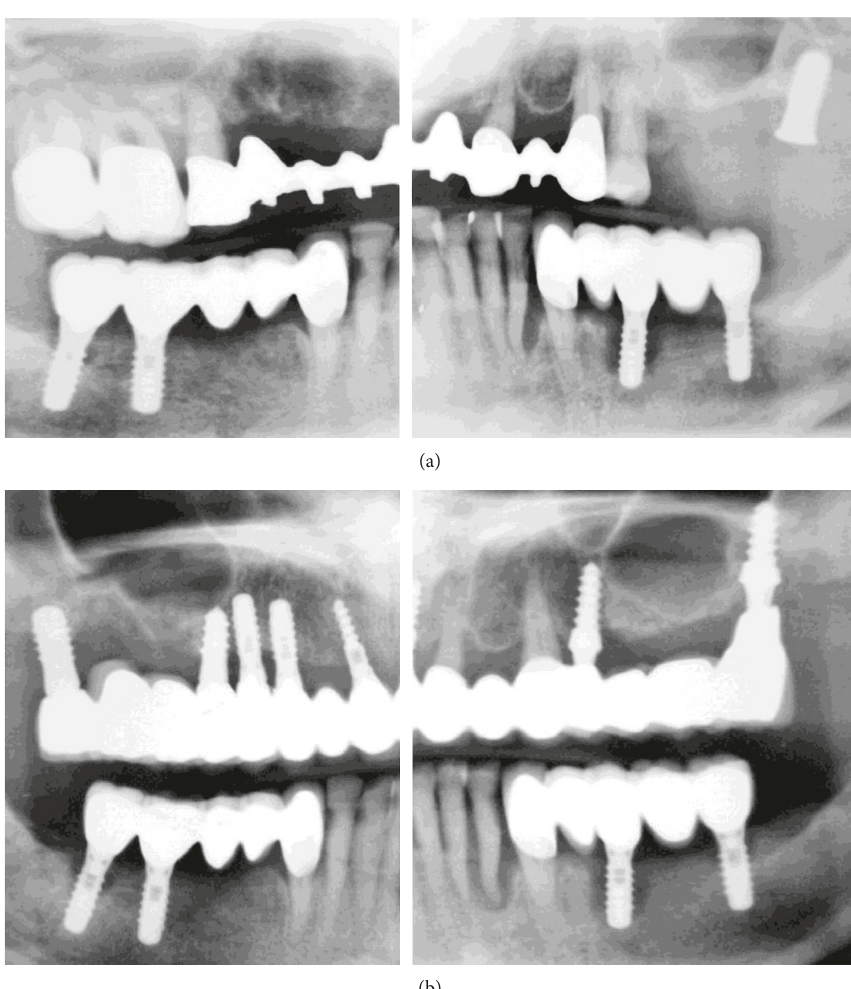
Figure 3: OPGs (original OPG of previous treatment modified for presentation reasons). (a) After extraction of tooth #14 and implant placement in position #15/16 (November 2006). (b) After maxillary restoration (November